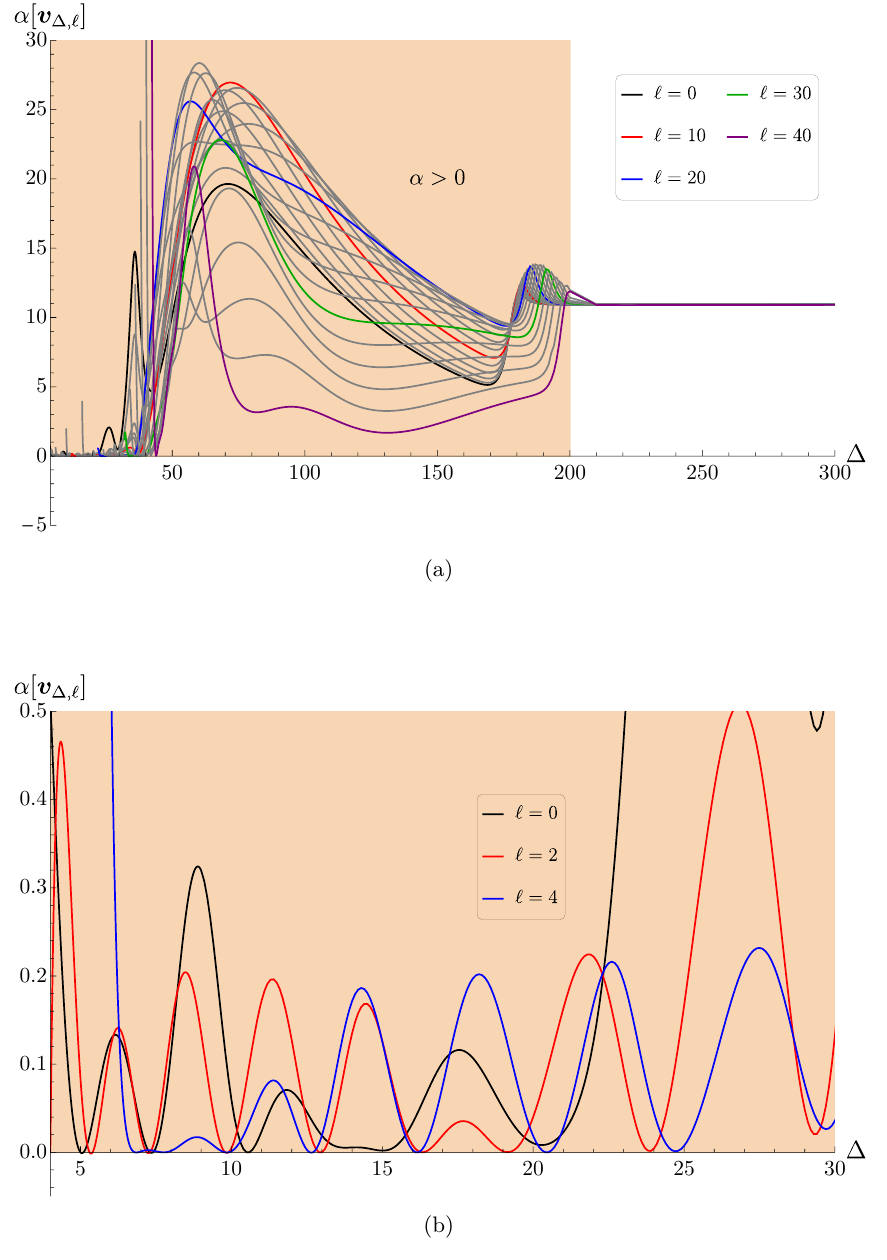
Figure 13 . (a): a functional establishing ∆ 0 ≤ 2 . 8688 at the Z 3 point of the SU (2) theory. Positivity is imposed only in the yellow shaded region, but we find that the functional is positive for all ∆ ≥ ¯∆ ‘ for each spin ‘ . (b): the functional above evaluated only for spins 0, 2, and 4, showing in more detail the low-lying extremal spectrum for these